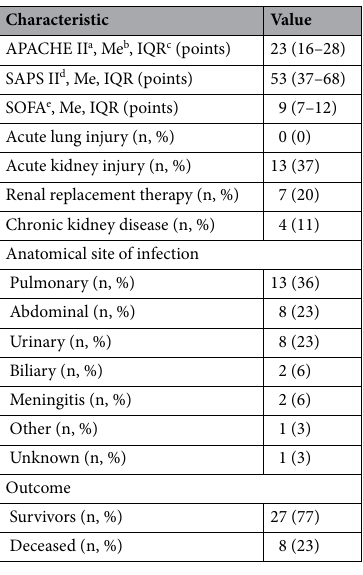
Table 1. Clinical characteristics of the study subjects. a Acute Physiology and Chronic Health Evaluation II. b Median value. c Interquartile range. d Simplified Acute Physiology Score II. e Sepsis Outcome Failure Assessment.